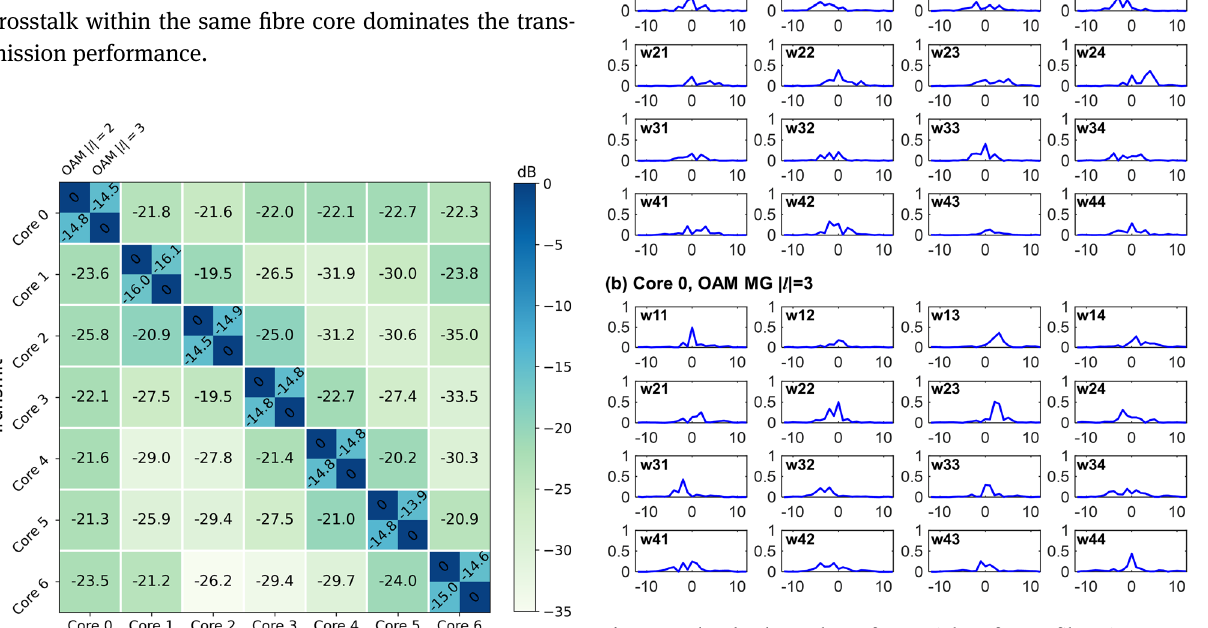
Figure8: The absolutevaluesoftap weightsof 16FIR filtersina4 × 4 l | = 3 of the central core. Figure 7: Measured system crosstalk matrix at 1550